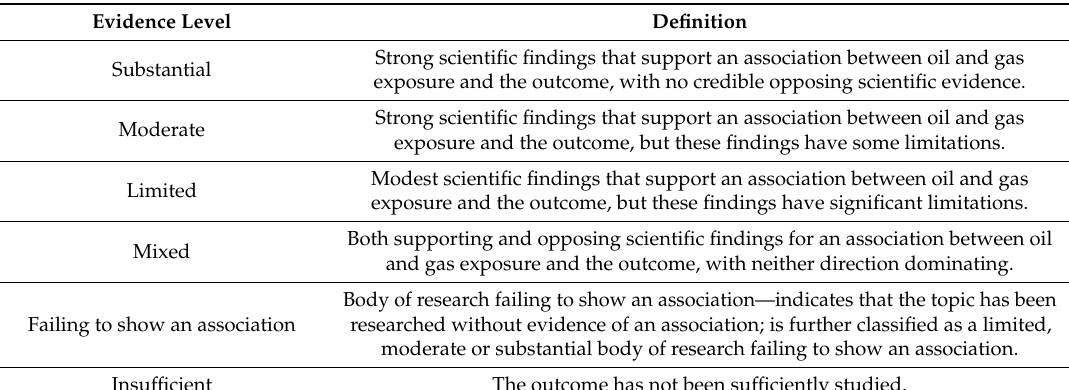
Table 2. Weight-of-evidence